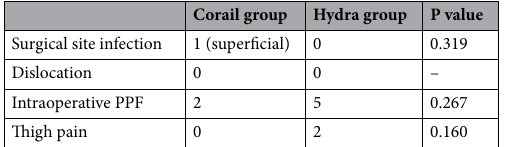
Table 3. Complications. PPF periprosthetic femoral